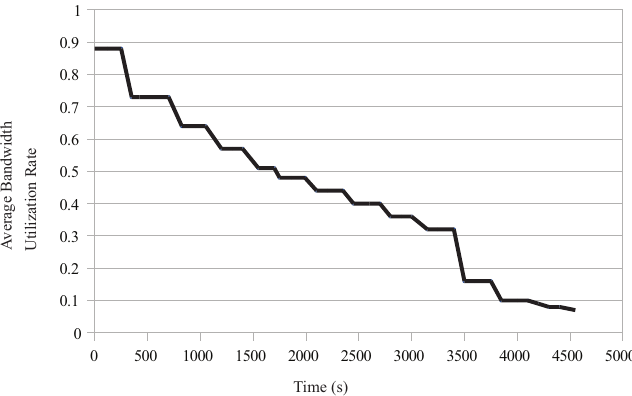
Figure 4. Average bandwidth utilization rate, as computed by